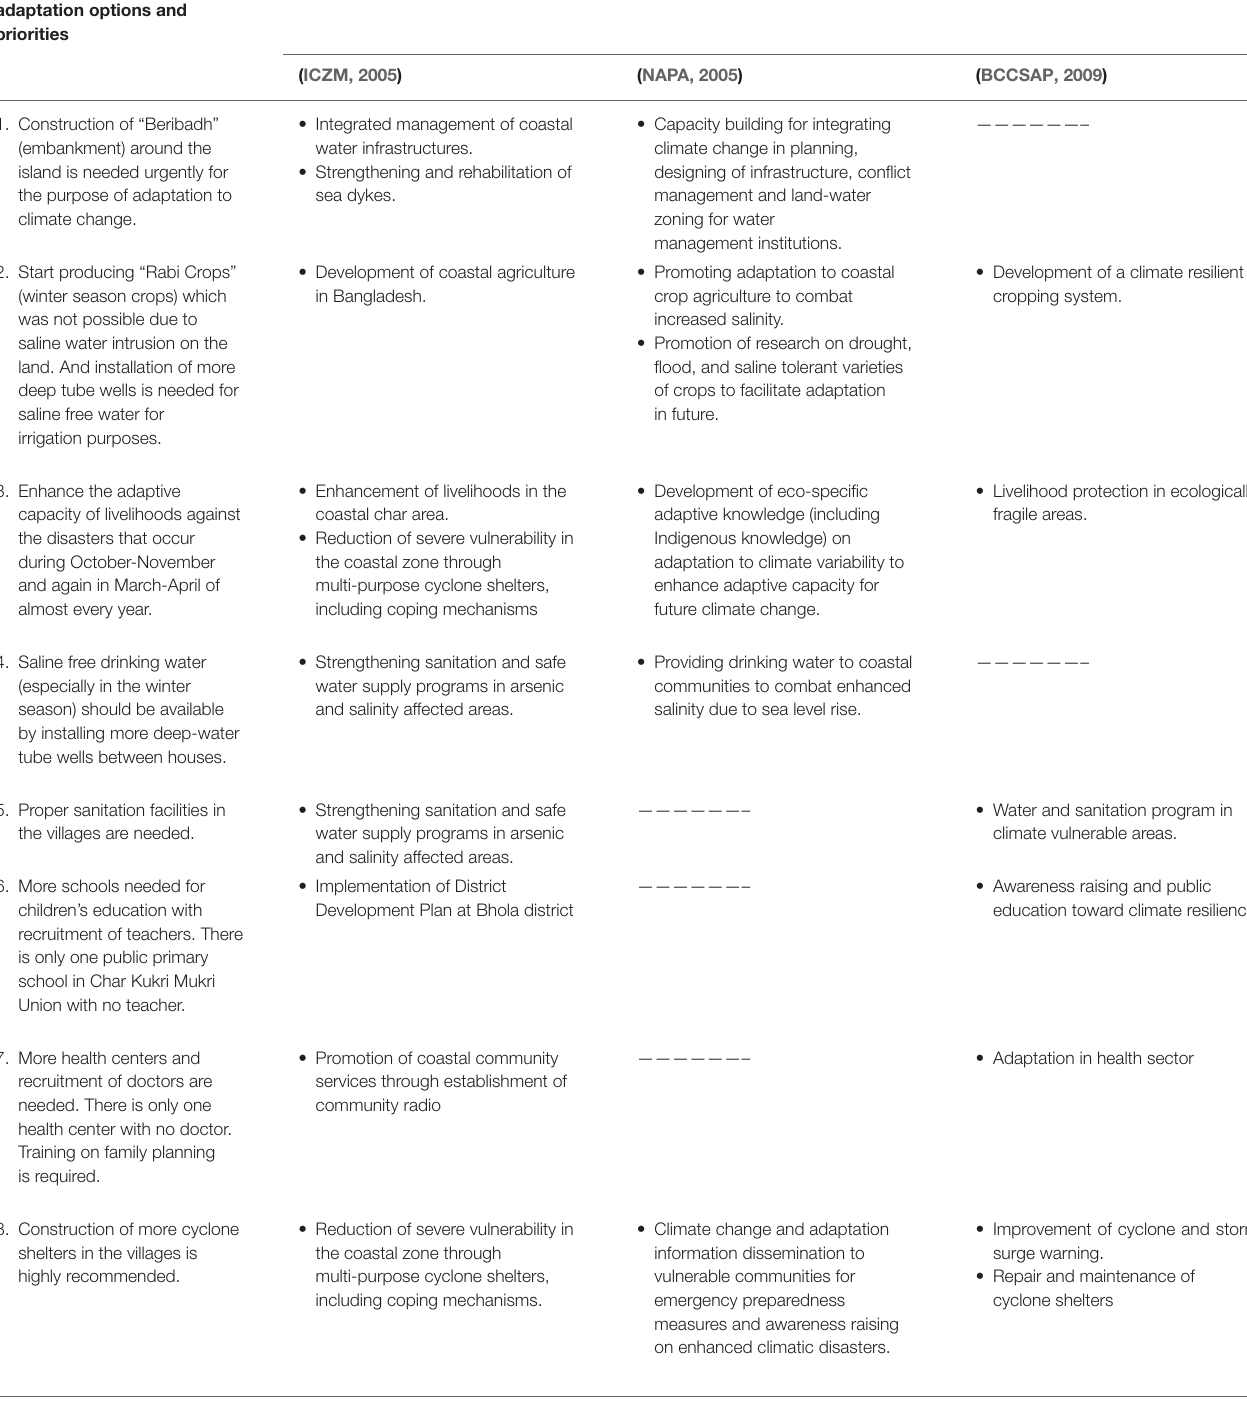
TABLE 2 | Prioritized adaptation options at local community level (Bhola District) as related to national plans and